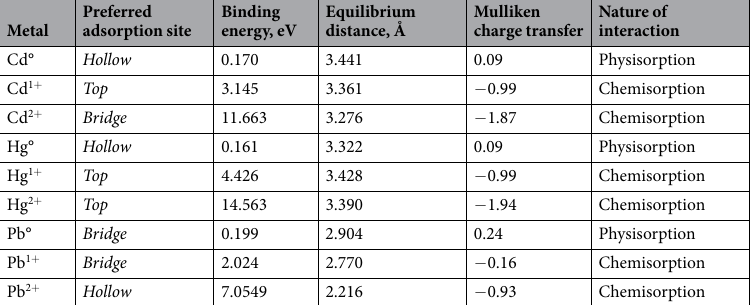
Table 1. Binding energy, equilibrium distance and charge transfer of neutral and charged Cd, Hg and Pb species on